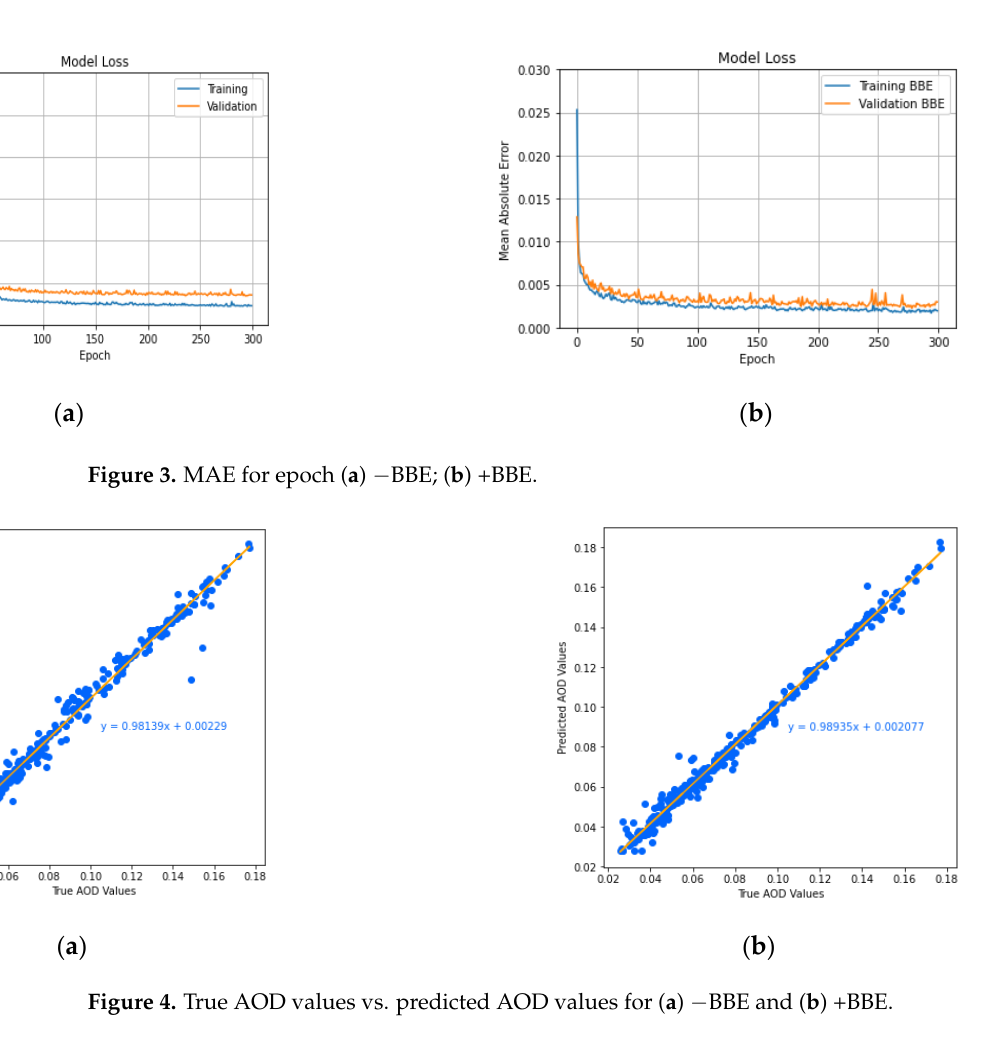
( b ) Figure 2. MAE for AOD prediction in ( a ) linear regression and ( b ) DNN. 3.2. DNN without BBE (-BBE) vs. DNN with BBE (+BBE) BBEs are significant contributors to atmosphere pollutants, specifically aerosol parti- cles in the Arctic region. In an attempt to improve AOD prediction accuracy, seven days’ worth of biomass burning event (BBE) data before the date of each determined AOD value was added to the DNN parameter list to account for long wind transport. Upon addition